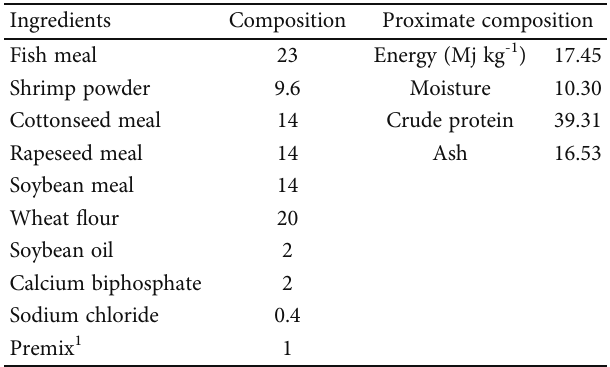
Table 1: Formulation and proximate composition of the basal diet